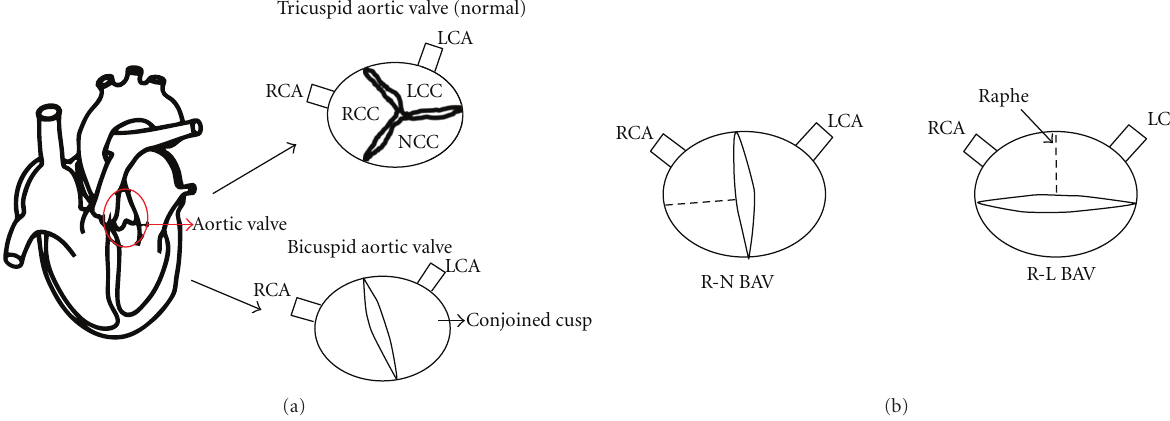
Figure 1: Schematic representation of a bicuspid aortic valve. (a) Transverse section through the aorta showing a normal aortic valve with three leaflets and their corresponding points of attachment to the aortic wall. A bicuspid aortic valve arises from fusion of two di ff erent cusps, resulting in the formation of a conjoined leaflet. (b) Schematic representation of the BAV subtypes. The R-N BAV arises from fusion of the right coronary cusp and noncoronary cusp whereas the R-L BAV results from the fusion of the right coronary cusp and left coronary cusp. LCA: left coronary artery; LCC: left coronary cusp; NCC: noncoronary cusp; RCA: right coronary artery; RCC: right coronary